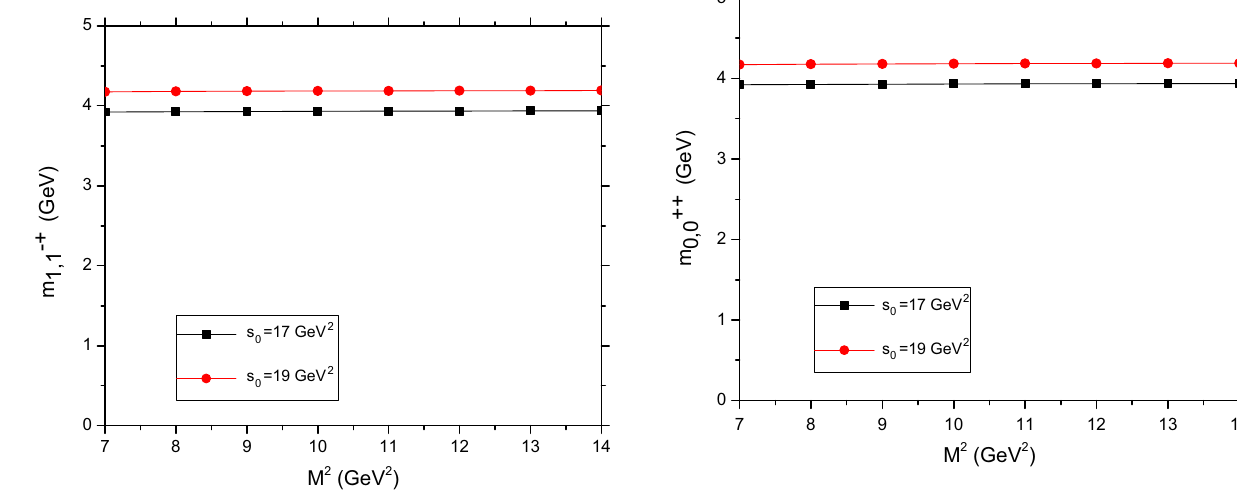
Fig. 6 Borel parameter dependence of J PC = 0 ++ meson mass from (cid:10) ( 0 ) μναβ for different s 0